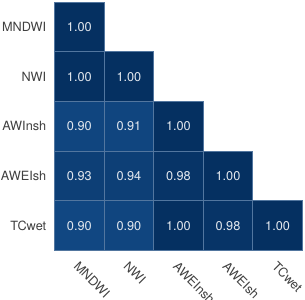
Figure 7. Correlation matrix between all indexes for Lake Ray Roberts in January 2017 (MNDWI, NWI, AWEI nsh , AWEI sh , TC wet